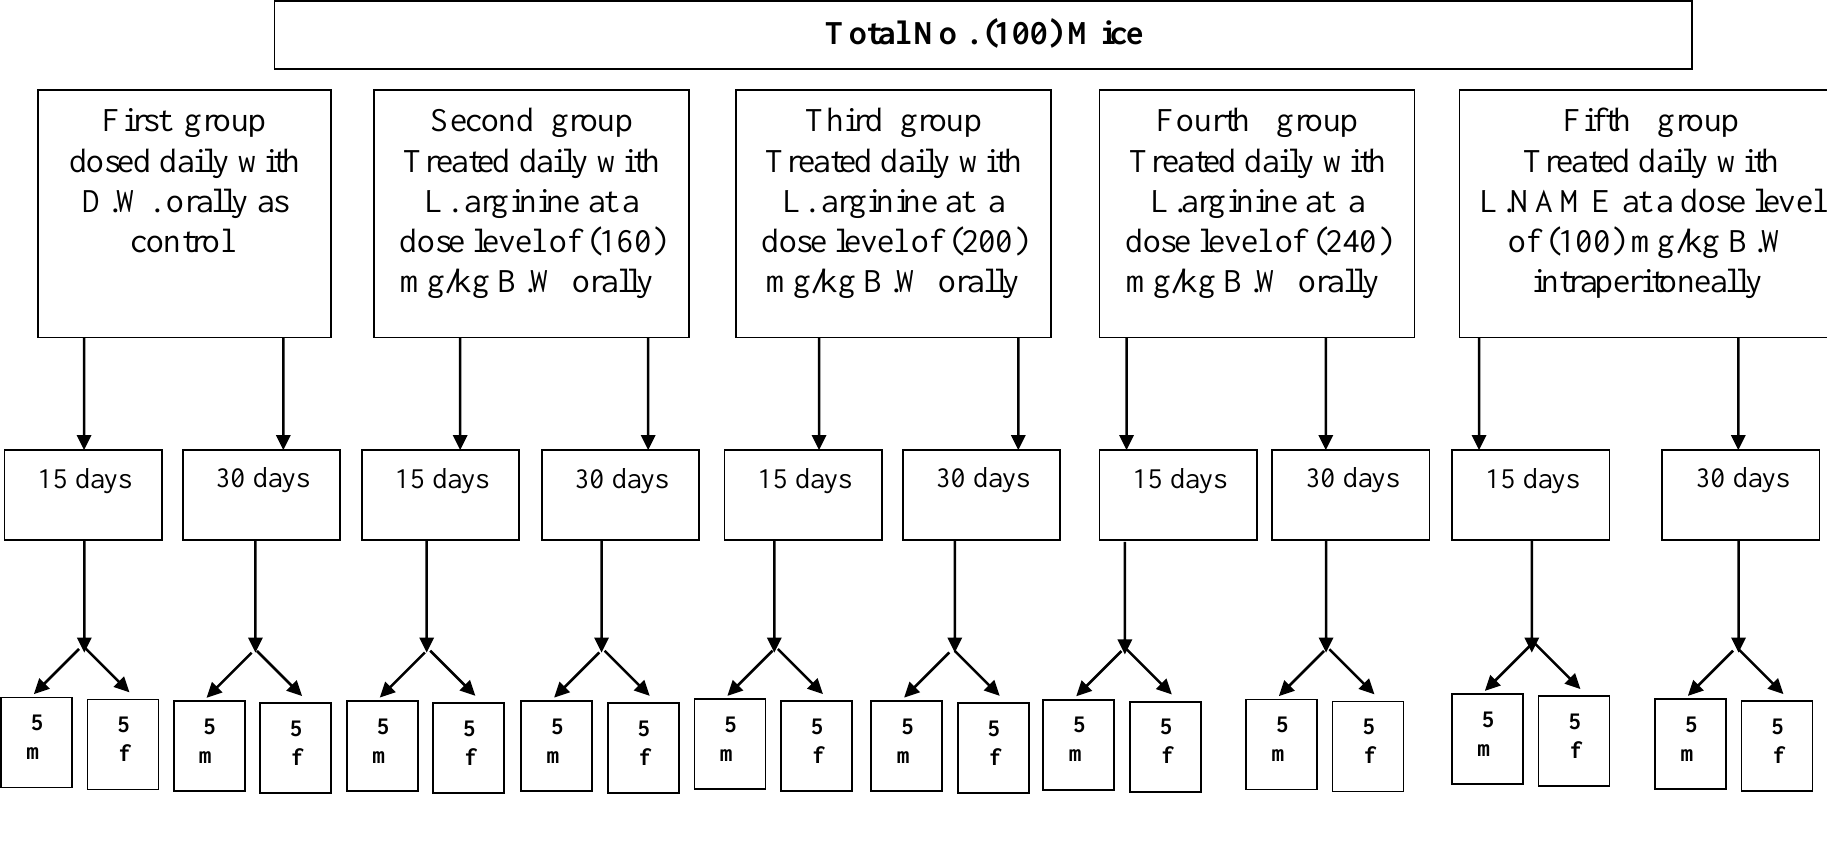
Figure (1): Experimental Design of Tail Flick and Hot Plate